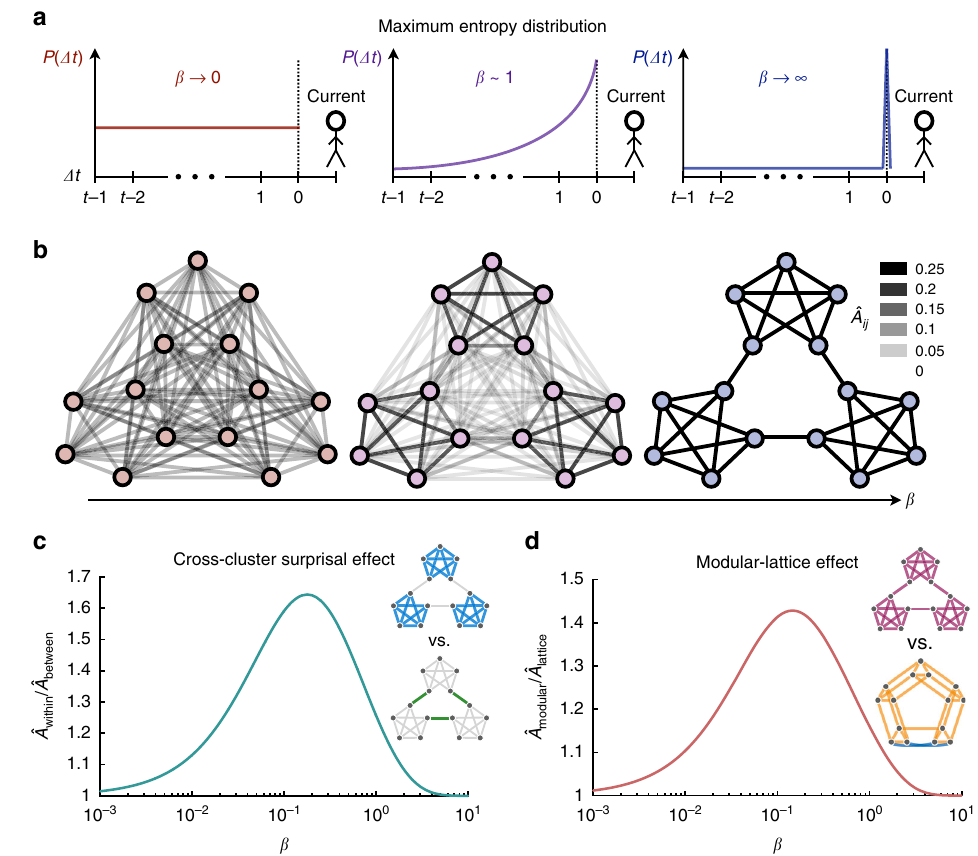
Fig. 3 A maximum entropy model of transition probability estimates in humans. a Illustration of the maximum entropy distribution P ( Δ t ) representing the probability of recalling a stimulus Δ t time steps from the target stimulus (dashed line). In the limit β → 0, the distribution becomes uniform over all past stimuli (left). In the opposite limit β → ∞ , the distribution becomes a delta function on the desired stimulus (right). For intermediate amounts of noise, the distribution drops off monotonically (center). b Resulting internal estimates ^ A of the transition structure. For β → 0, the estimates become all-to-all, losing any resemblance to the true structure (left), while for β → ∞ , the transition estimates become exact (right). At intermediate precision, the higher-order community structure organically comes into focus (center). c , d Predictions of the cross-cluster surprisal effect ( c ) and the modular-lattice effect ( d ) as functions of the inverse temperature β